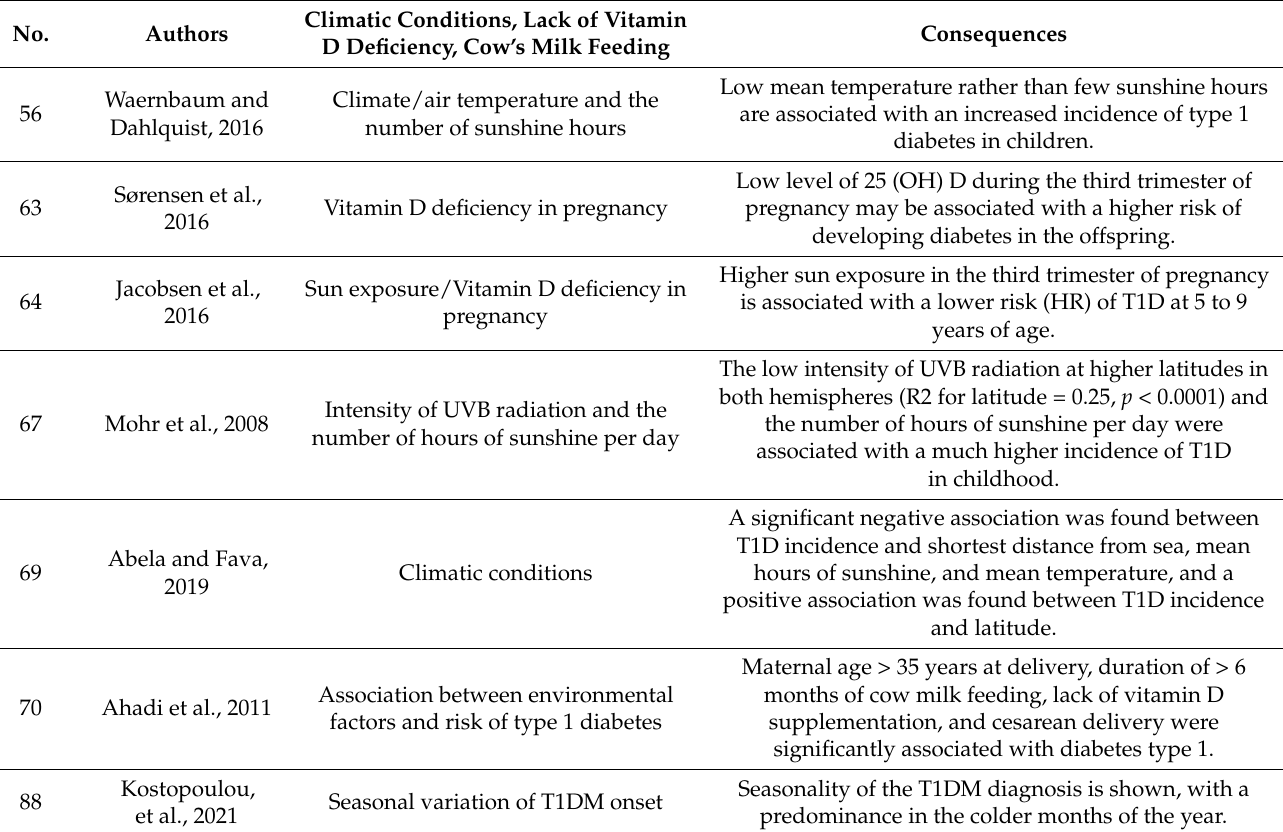
Table 1. The climatic conditions, vitamin D deficiency, cow’s milk feeding, and the risk of developing type 1 diabetes.